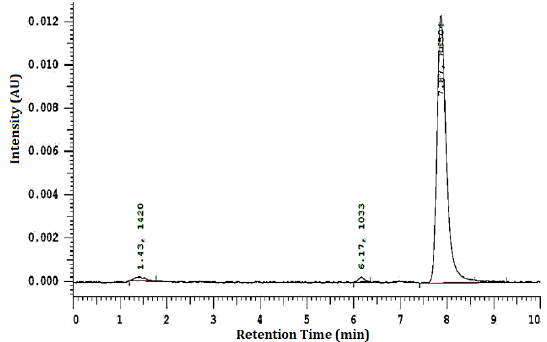
Figure 3. Chromatogram of isolated piperine at 340 nm